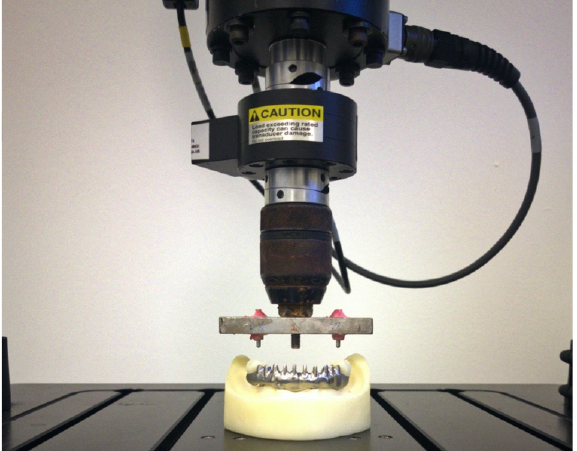
Figure 3. Electrodynamic testing machine (MTS-Acumen 1) simulating loading cycles on the 7-mm distal cantilever of the implant supported prosthesis.